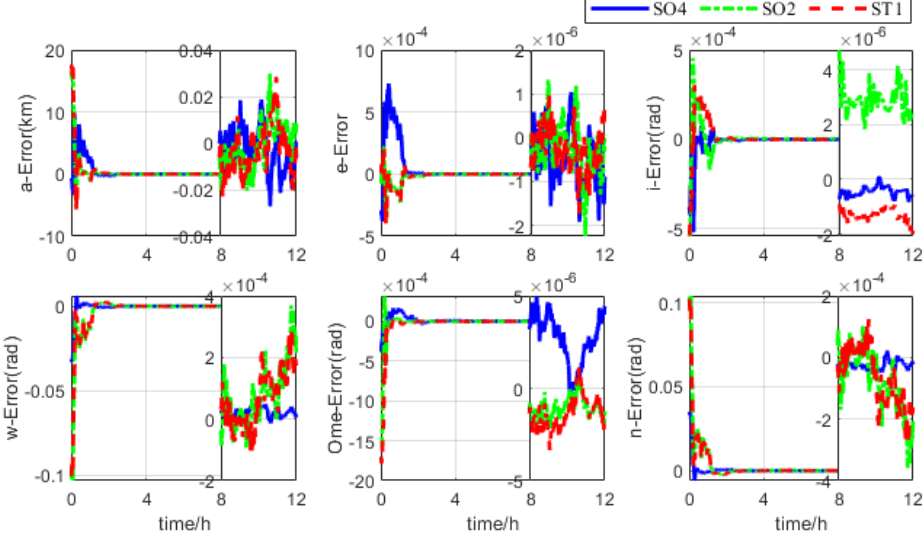
Figure 11. Errors of orbit elements in symmetric case.